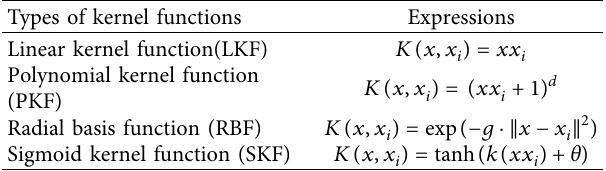
Table 1: Kernel functions in SVM